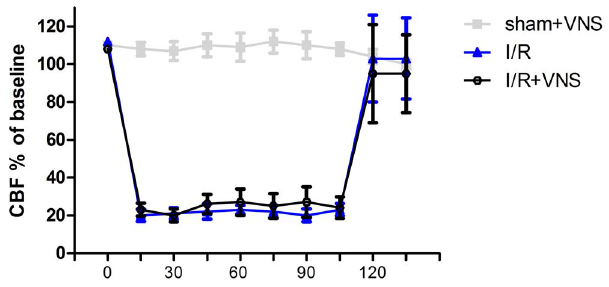
Figure 4. Effect of VNS on regional blood flow of right middle cerebral artery. Changes of CBF in the right middle cerebral artery territory in three group (n=8/group). Data are shown as mean 6 SEM.(P .